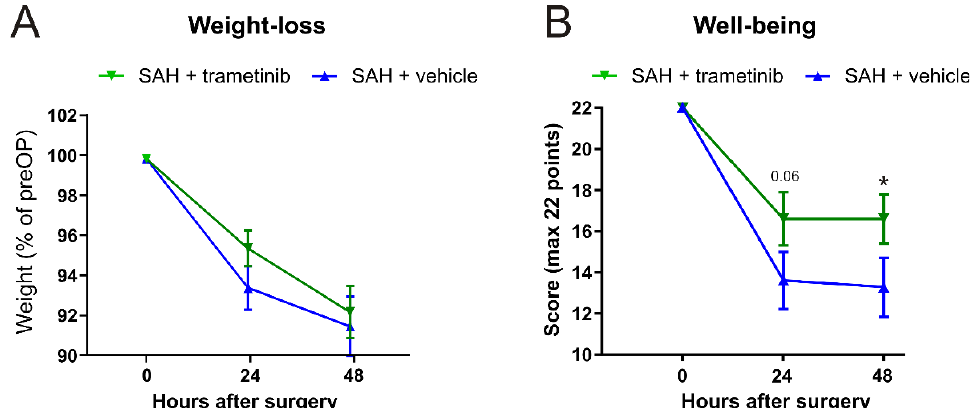
Figure 6. Weight loss and general well-being . ( A ) Animals were weighed at the starting point and after 24/48 h. There was a significant weight loss in both groups, with no significant effect of the trametinib treatment. ( B ) The general well-being ratings used a 22-point scoring system. Multiple t-tests with multiple testing correction (* p < 0.05) were used for statistical analysis.